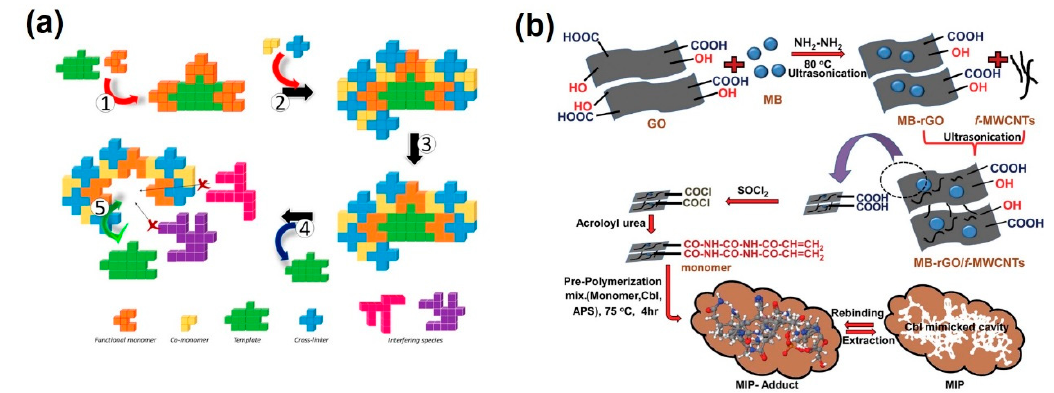
Figure 4. ( a ) Scheme for the preparation of a molecularly imprinted polymer (MIP). ( 1 ) First, template molecule (T) and functional monomers (FM) are mixed to get the complex FM-T. ( 2 ) The rest of the components of the pre-polymerization mixture are added, i.e., co-monomers (CM) and cross-linker (CL). ( 3 ) After the addition of a radical initiator (thermal or photochemical) or a catalyst (acid or base), polymerization takes place. ( 4 ) T is removed resulting in a pocket within the polymeric matrix. ( 5 ) T re-binds the selective cavity while other potential interfering species are blocked due to limitations in terms of size, shape and/or functional group distribution [46]. ( b ) Schematic presentation of MB-rGO/f-MWCNTs/AU-MIP Development. Reproduced with permission [52]. Copyright 2018 ACS publication.